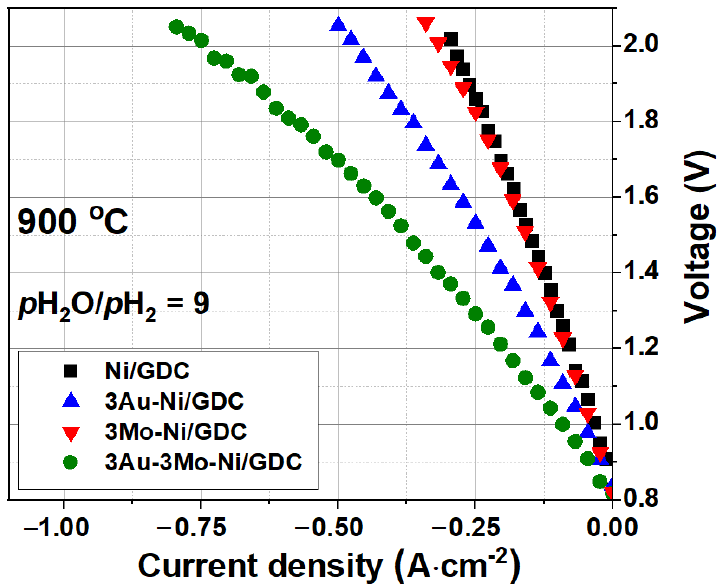
Figure 1. The I-V curves at 900 °C for an electrolyte-supported single cell comprising ( ■ ) Ni/GDC, ( ) 3Au-Ni/GDC, ( ▼ ) 3Mo-Ni/GDC, and ( ● ) 3Au-3Mo-Ni/GDC as the fuel electrode and LSCF as the oxygen electrode. Adapted with permission from [29].